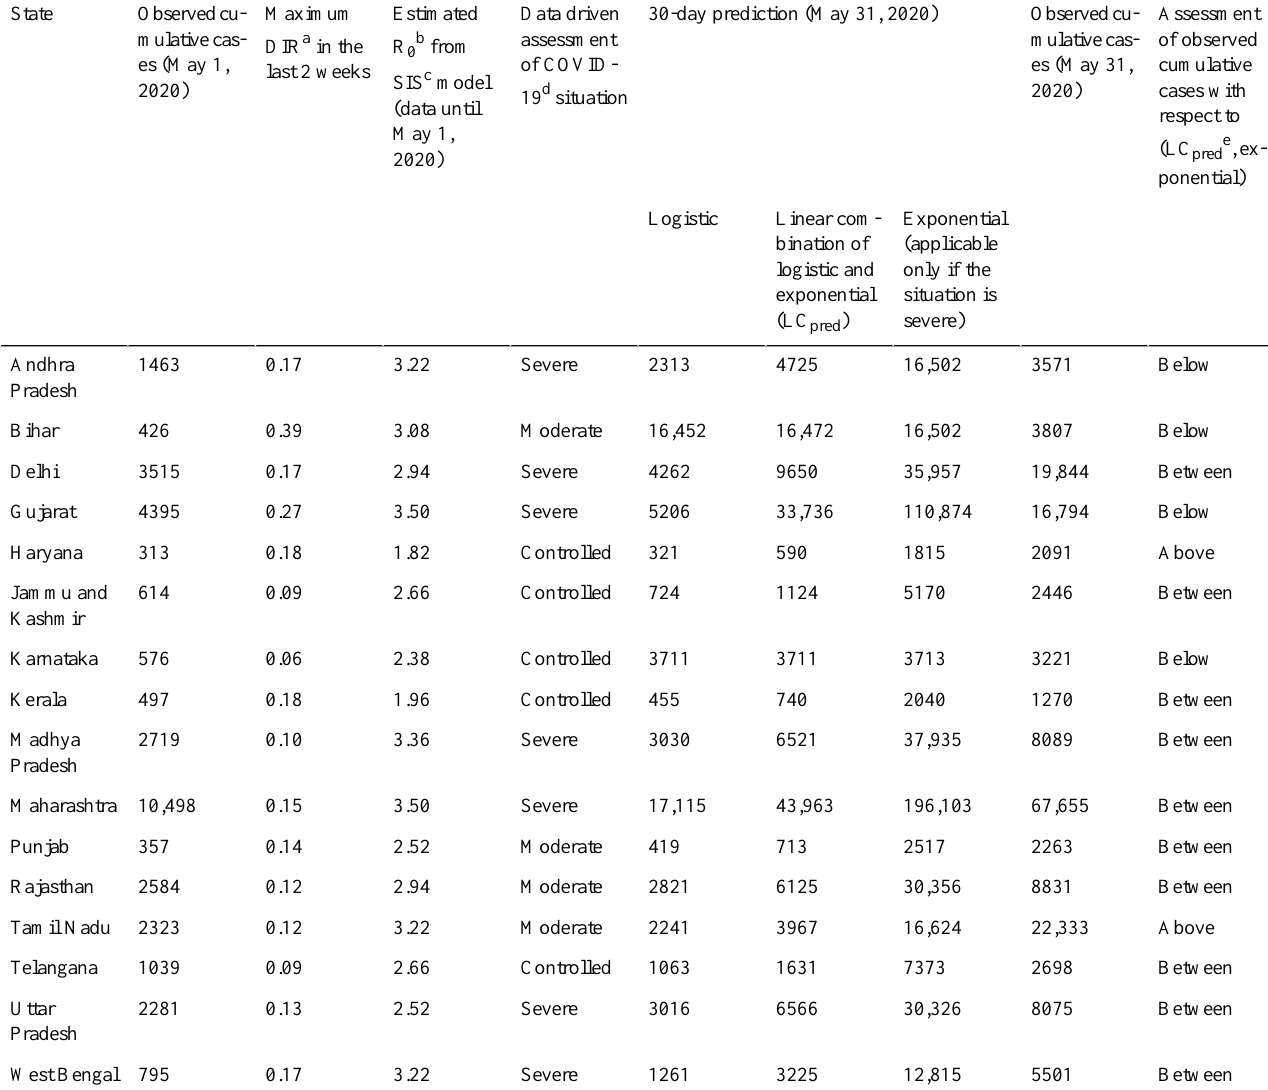
Table 1. Data-driven assessment and 30-day prediction using the logistic and exponential models, and their linear